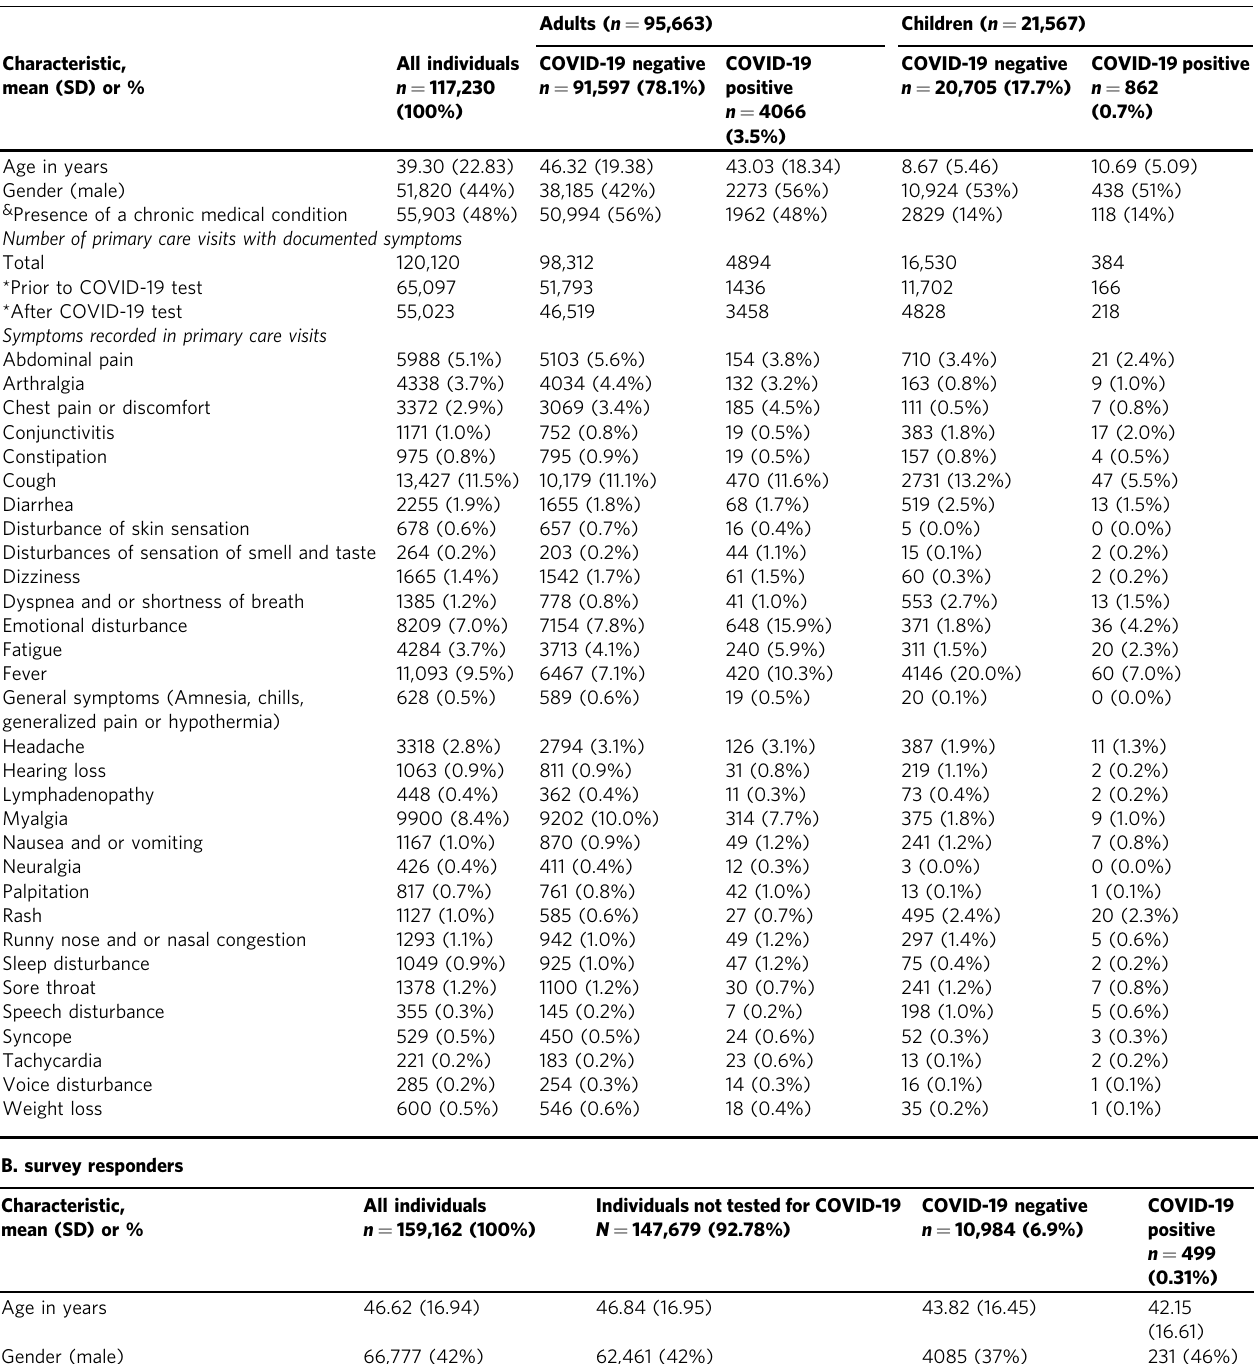
Table 1 Baseline characteristics of the study